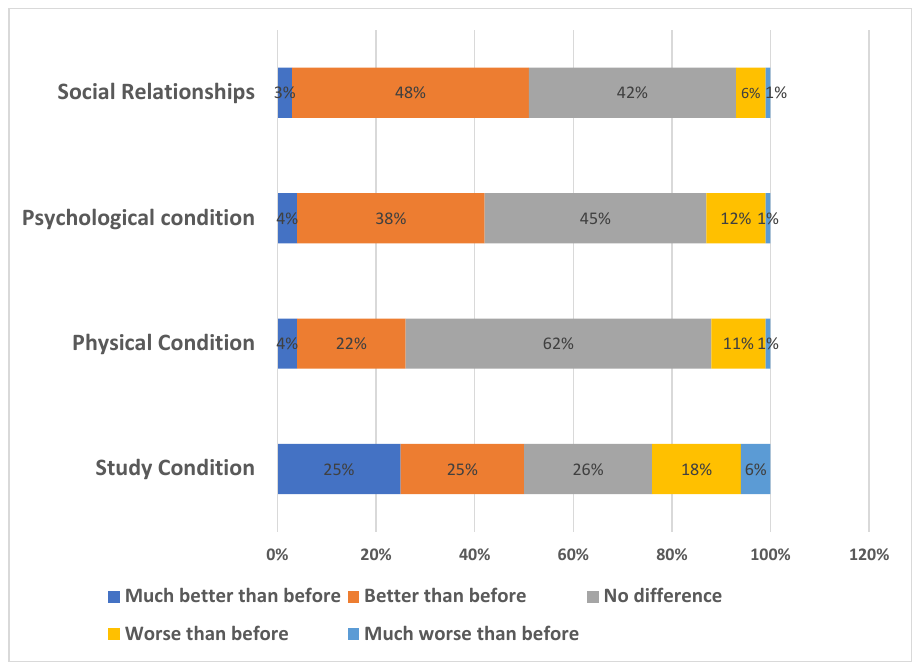
Figure 2. Pupils’ responses regarding a change in some conditions after COVID-19.